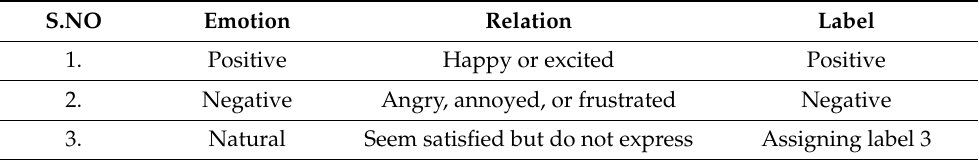
Table 4. Sentiment Analysis Examples with Label.